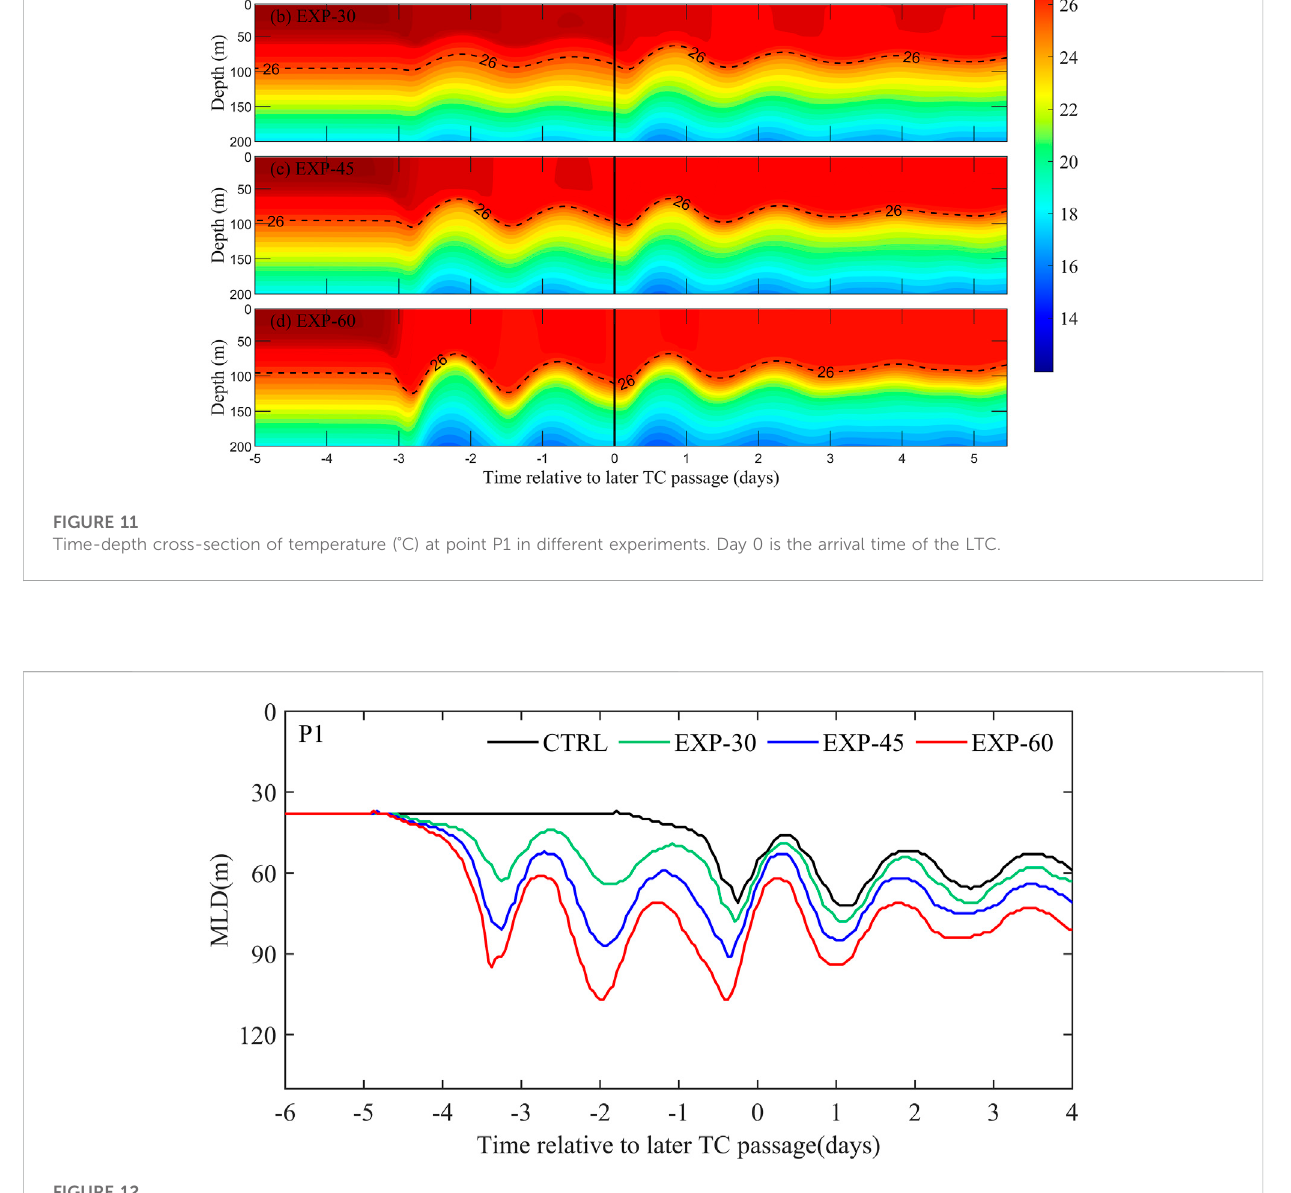
water (Zhang et al., 2016). There was a depth difference in the warm temperature anomaly induced by the vertical mixing among the different experiments (Figures 13a1 – d1) due to the difference in ETC-induced mixed layer depth. The amplitude of the warm temperature anomalies induced by the vertical mixing was larger